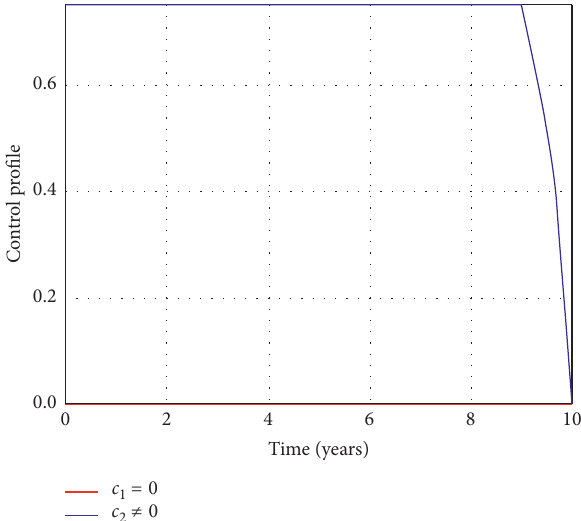
Figure 8: A graph showing the effectiveness of the two control � 0 and c � 2 . 2353. ≠ 0 at R c 2 1 2 0 and c in the infected population to check its effect on measures c 1 2 the spread of cholera.